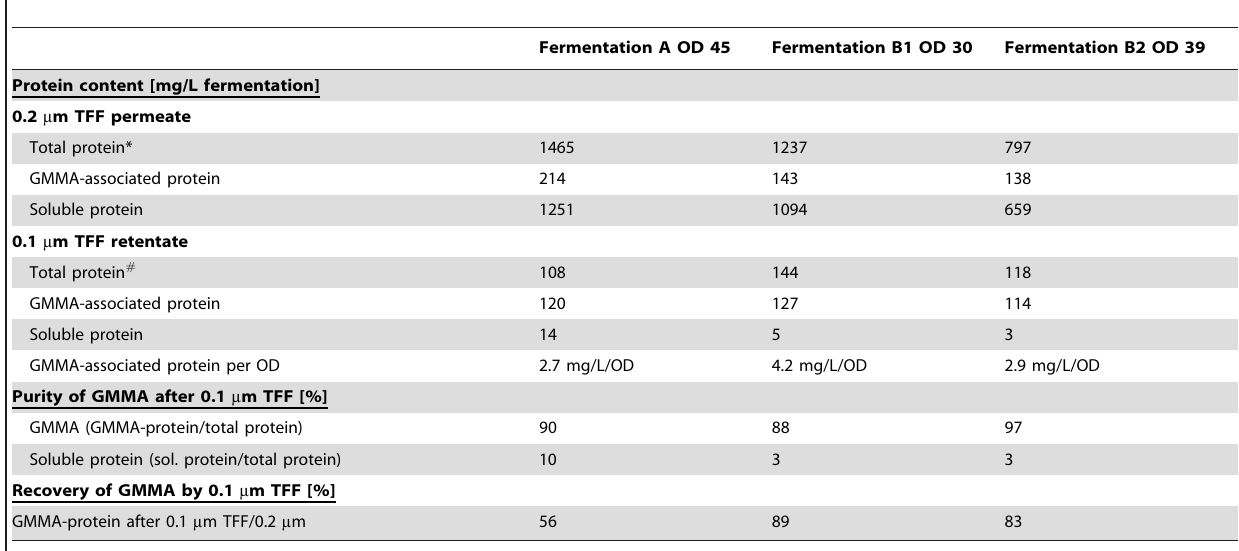
Table 3. Yield, purity, and recovery rate of GMMA by the high yield production